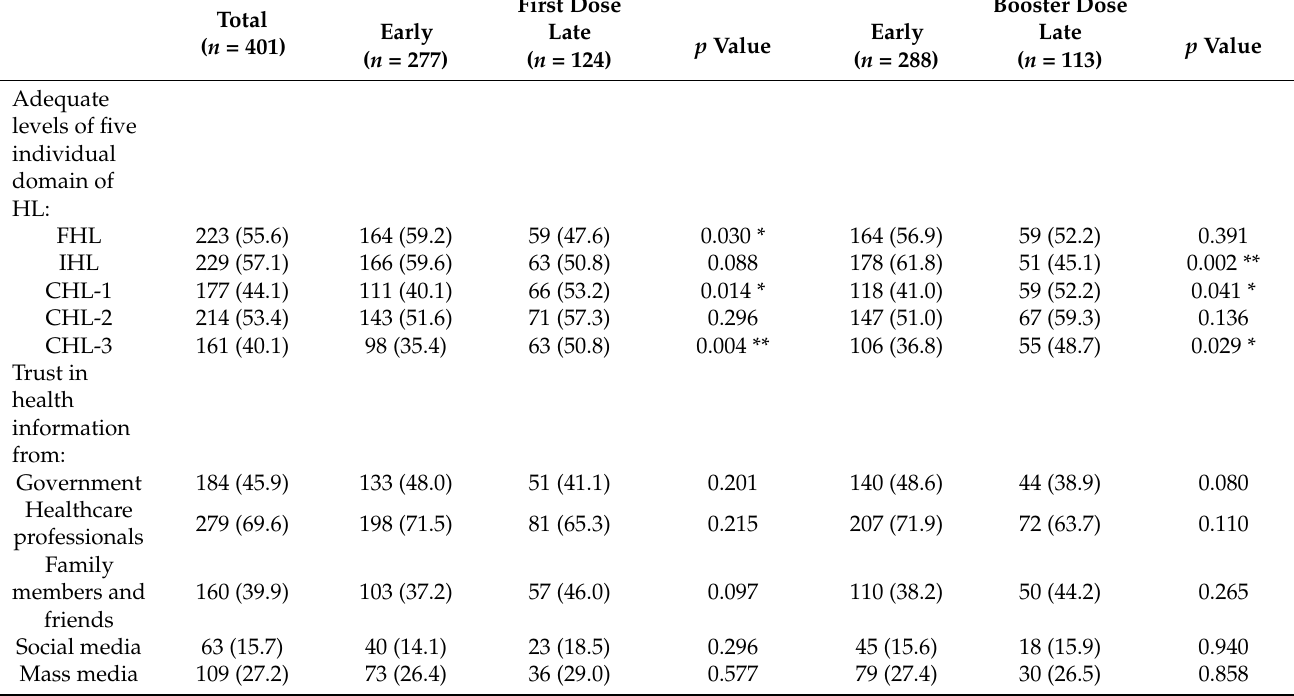
Table 2 indicates that the proportion of trust in health information from